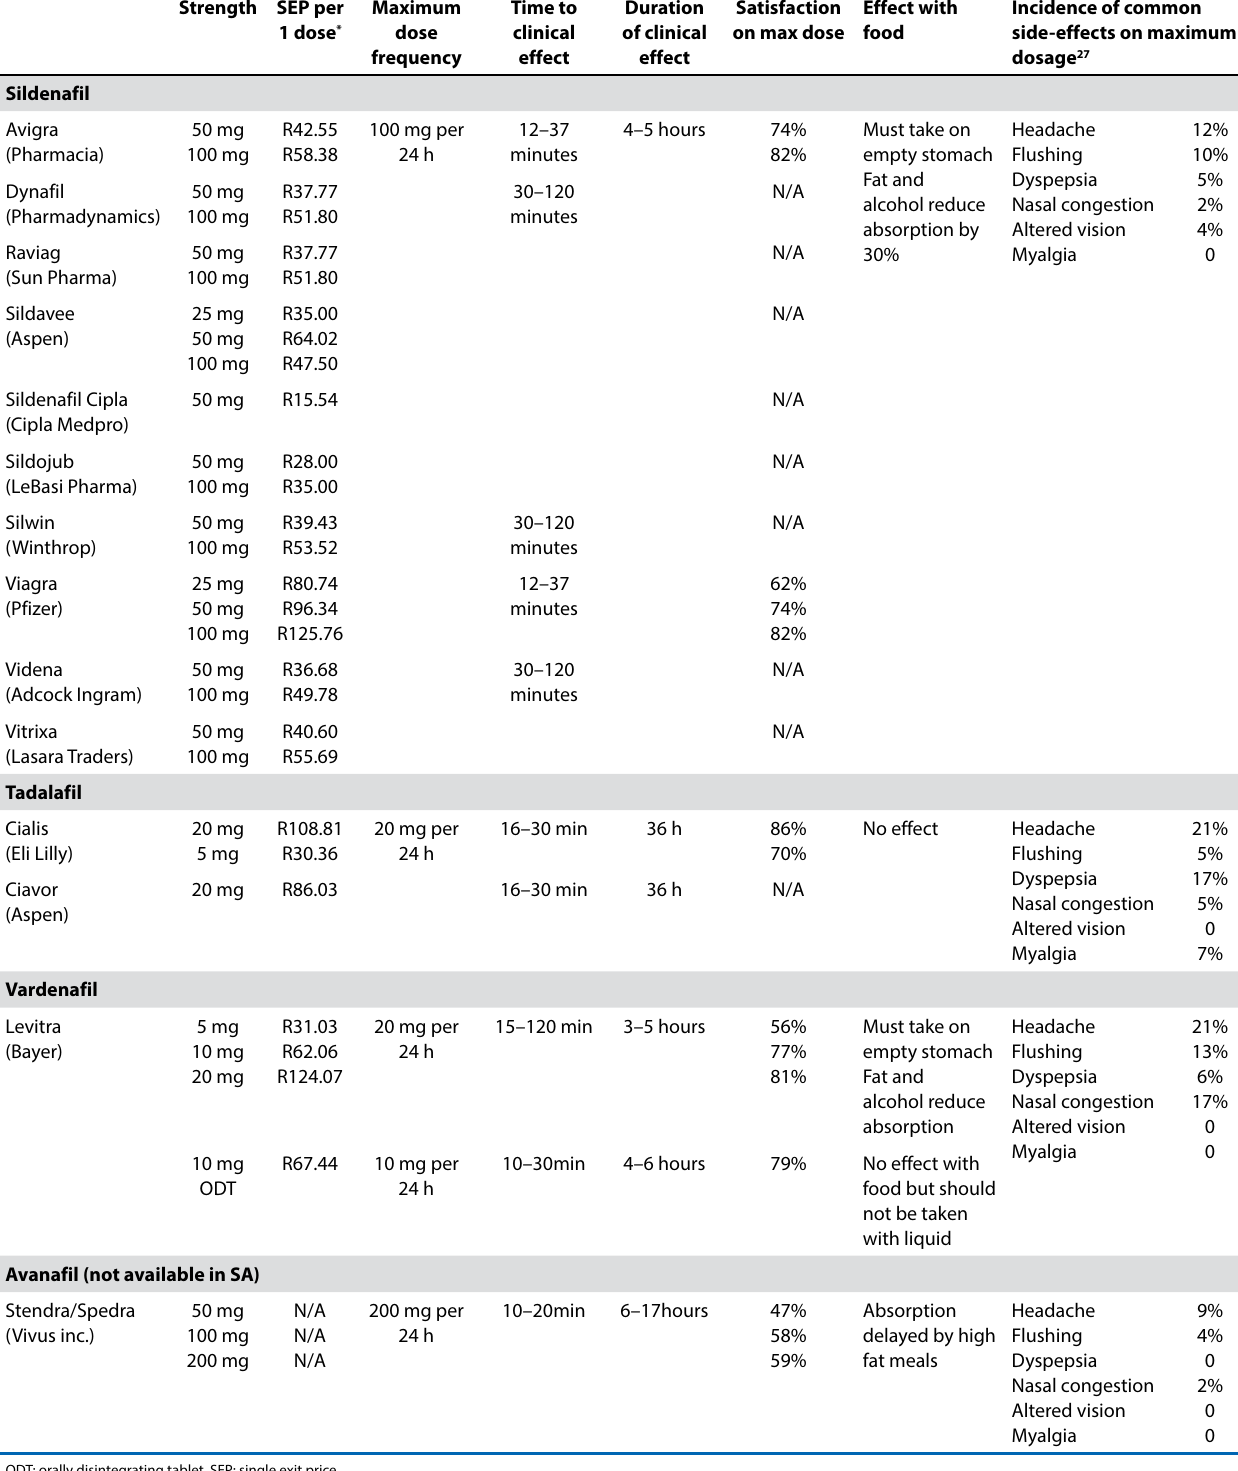
Table III. Comparative summary of currently available PDE-5 inhibitors Strength SEP per 1 dose